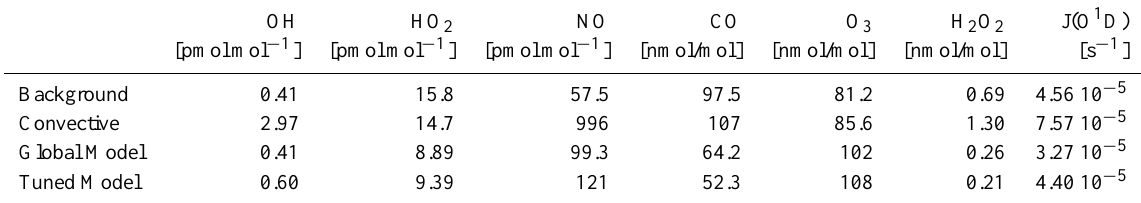
Table 2. Summarized are mean values of observed and simulated (global model) trace gas mixing ratios and a photolysis frequency. The observations displayed are mean values of the four flights presented here and are separated for convectively (convective) affected and unaf- fected (background) air masses. Tuned model indicates a simulation of the global model with increased photolysis frequencies to match the observation.